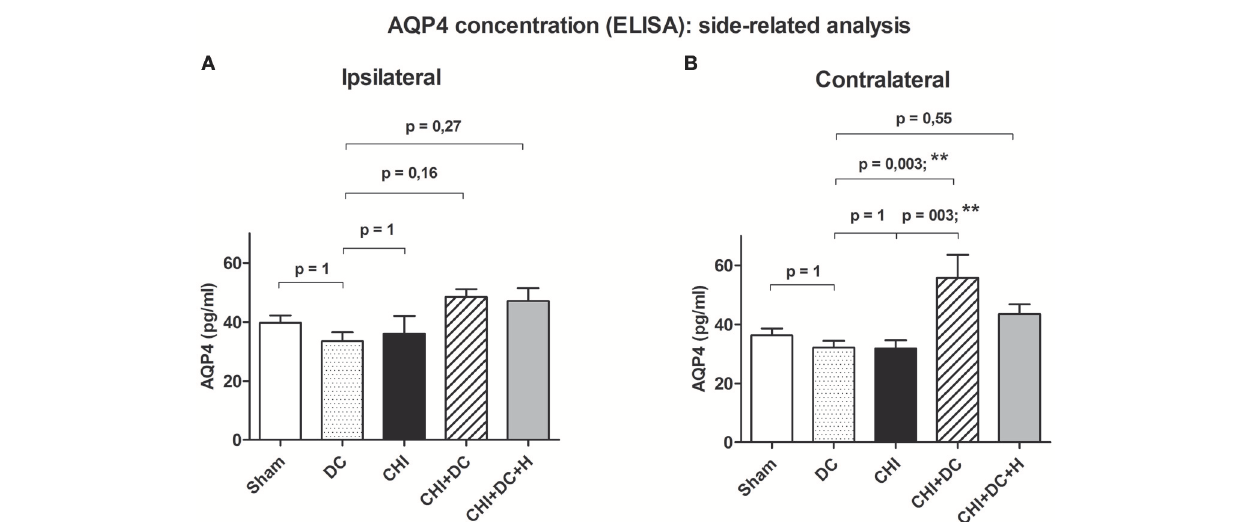
FIGURE 5 | Histogram presenting concentration of AQP4 24h after trauma/sham injury according to ELISA assessment. This part of analysis involves the data pooled and averaged separately for the contralateral hemisphere (at the level of ROI plus outside the ROI) and for the ipsilateral one (again, at the level of ROI plus outside the ROI). (A) According to ANOVA, the differences between AQP4 level values, averaged for ipsilateral hemispheres were not significantly different between the treatment groups. (B) Analogous analysis in contralateral hemispheres revealed significant raise in AQP4 concentration in animals subjected to trauma and decompressive craniectomy as compared to non-traumatized reference group as well as to trauma-only group (CHI + DC vs. DC, p < 0.01, **; CHI + DC vs. CHI, p < 0.01, **). Similar to global pooled analysis, this effect could not be seen in group where hypothermia was added to the treatment (CHI + DC + H vs. DC, p > 0.05, ns). CHI, closed head injury; DC, decompressive craniectomy; H, hypothermia; ROI, region of interest.